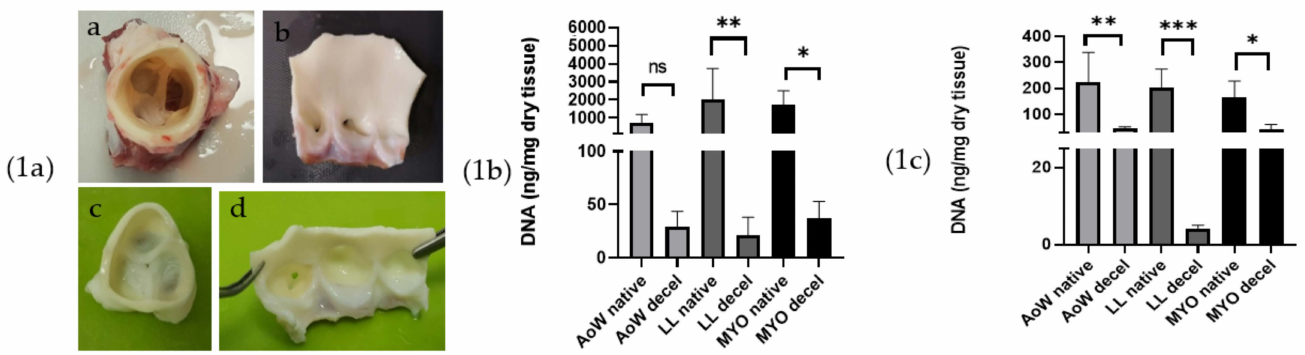
Figure 1. Macroscopic analysis of native ( a , b ) and decellularized ( c , d ) porcine aortic valve ( 1a ). DNA quantification (ng/mg of dry tissue) comparative analysis on native and decellularized tissues performed by Nanodrop ( 1b ) and Qubit assay ( 1c ). Data were analyzed by one-way ANOVA ( p < 0.05). There was a significant difference between native and corresponding decellularized tissues denoted by *, **, *** the level of significance from lower to highest p values, ns = not